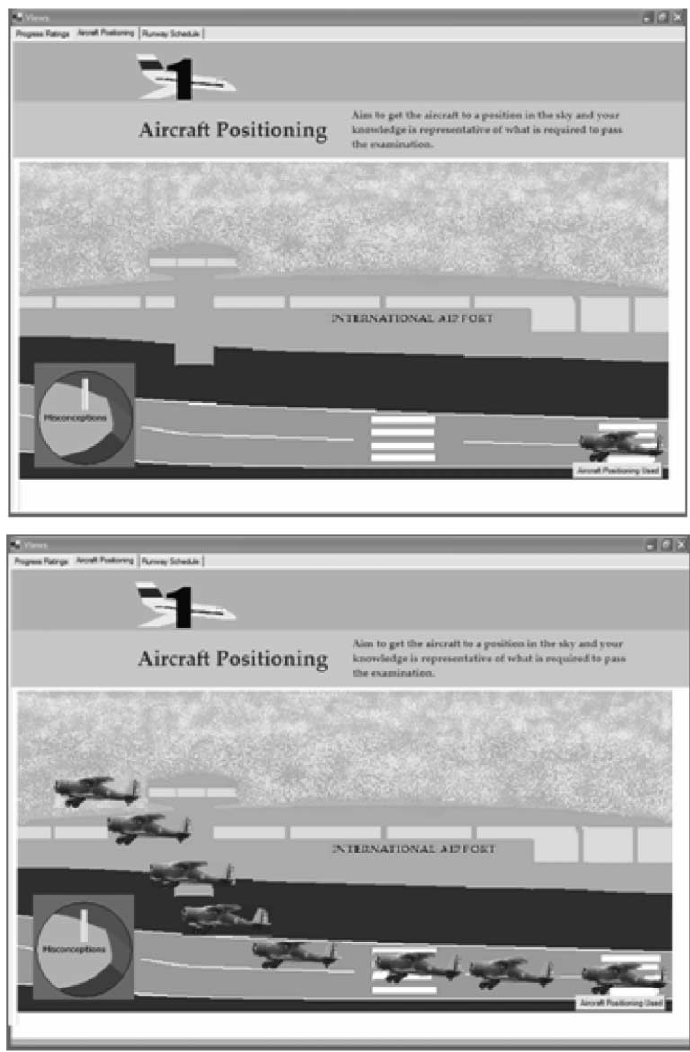
Figure 3. The aircraft positioning learner model view.